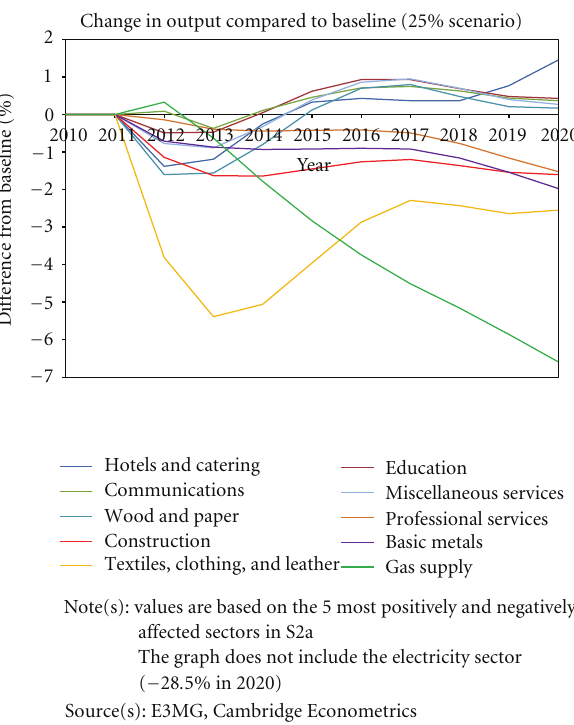
Figure 7: Selected output e ff ects under 25% reduction